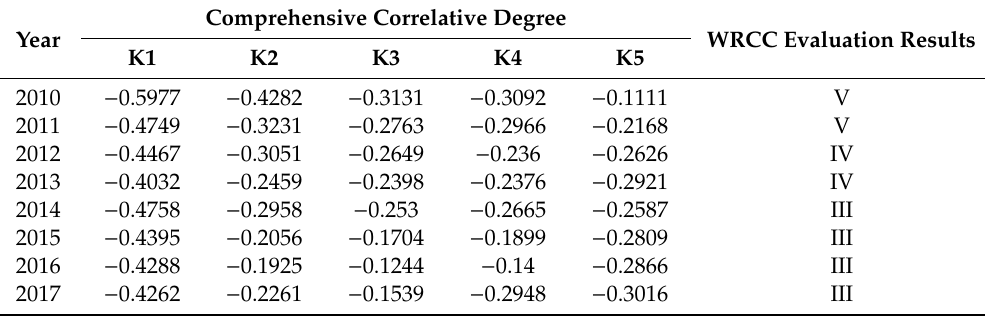
Table 5. Calculation results of the matter-element evaluated from 2010 to